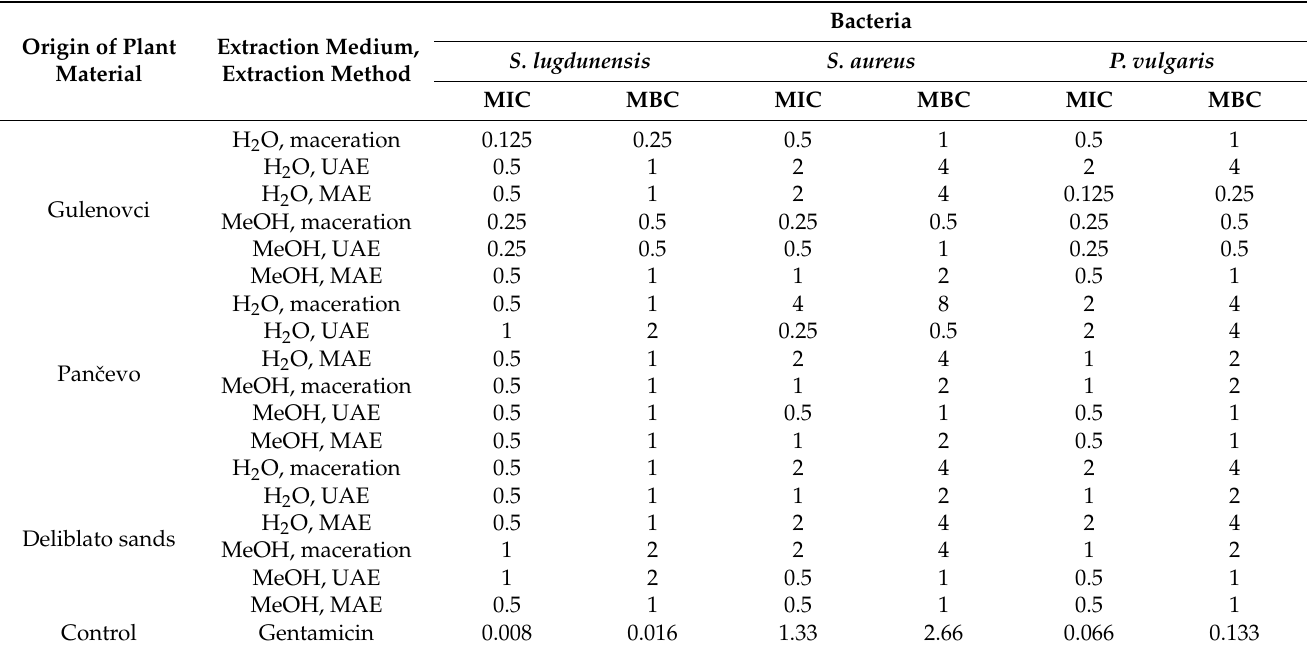
Table 3. Antibacterial activity of Paeonia tenuifolia L. water and methanolic extracts (MIC and MBC, mg/mL).